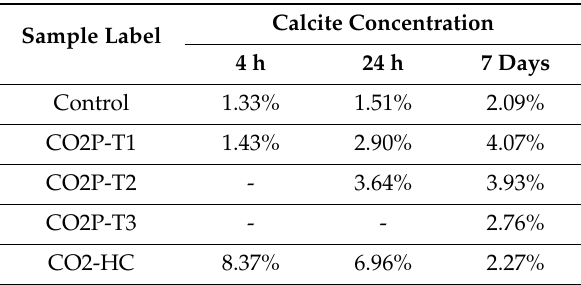
Table 5. Calcite concentrations of the